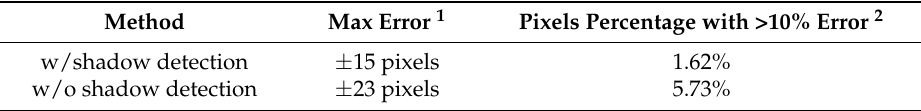
Table 1. Reconstruction error